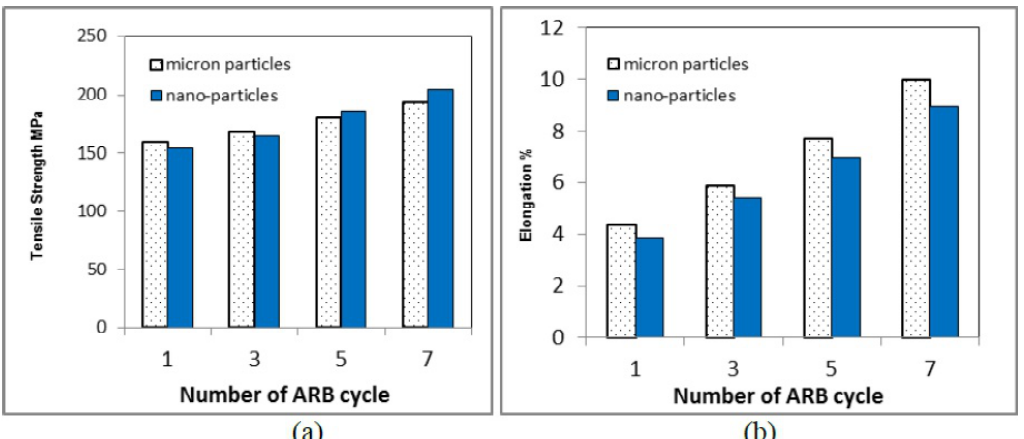
Fig. 9. The comparison of (a) the tensile strength and (b) the elongation of the composites with the different reinforced particle